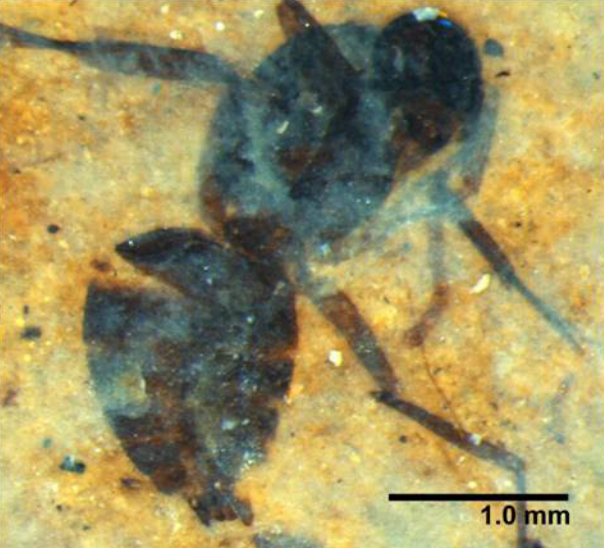
Fig 8. Holotype male, Lasius glom (USNM#